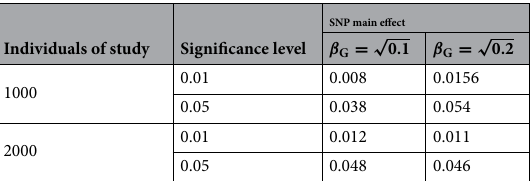
Individuals of study